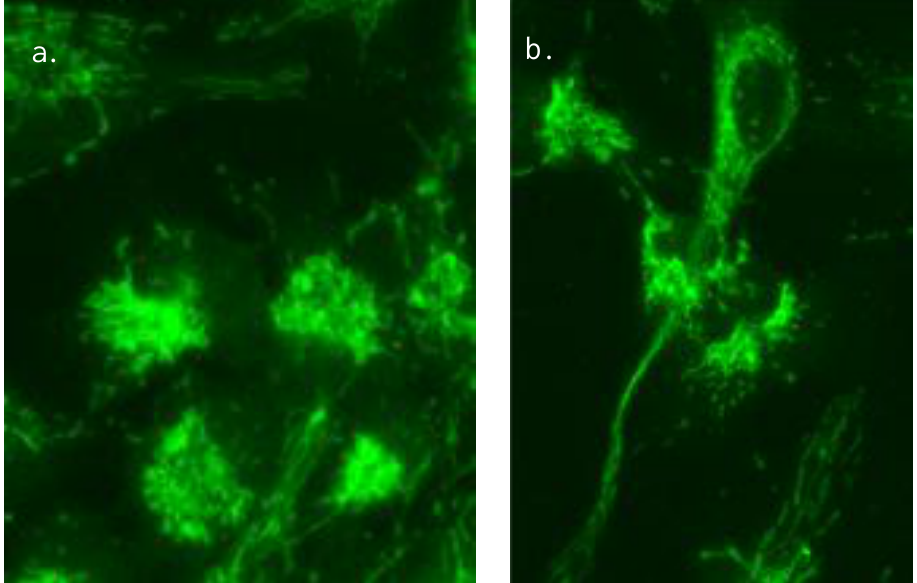
Figure 3. Human neural stem cells showing mitochondria (green) in progenitors with (a) perinuclear staining, and (b) more cytoplasmic staining. a.